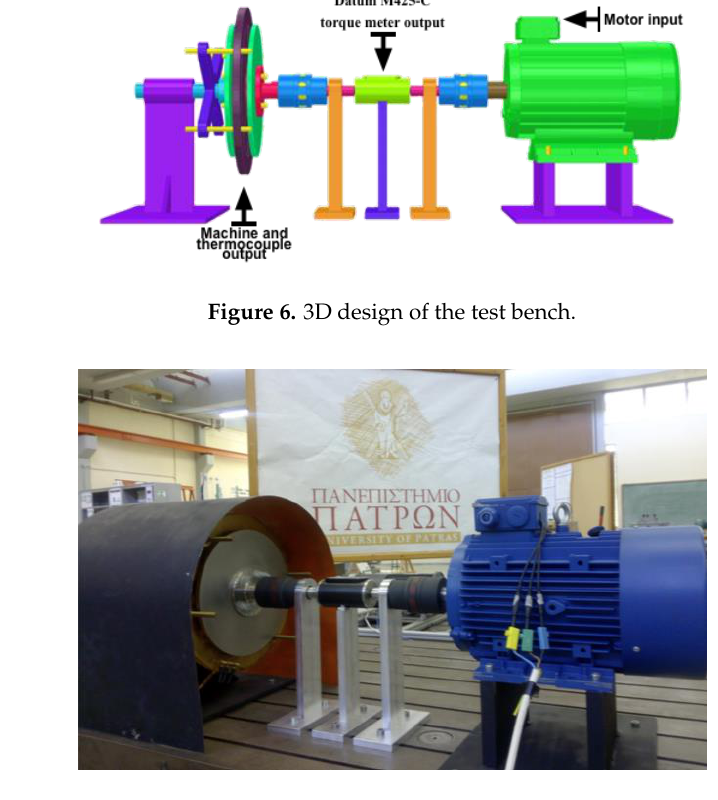
Figure 7. Constructed test bench.